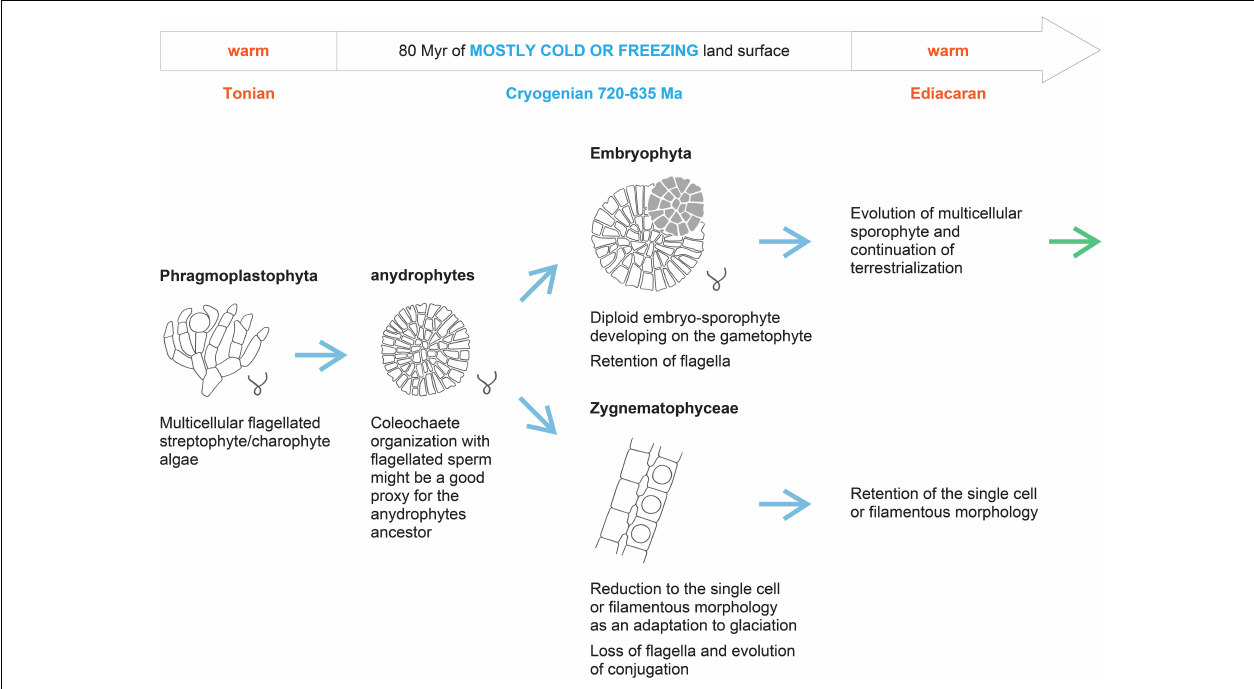
FIGURE 3 | Hypothetical scenario of anydrophyte establishment and Zygnematophyceae split off by the evolutionary reduction under the extended Cryogenian